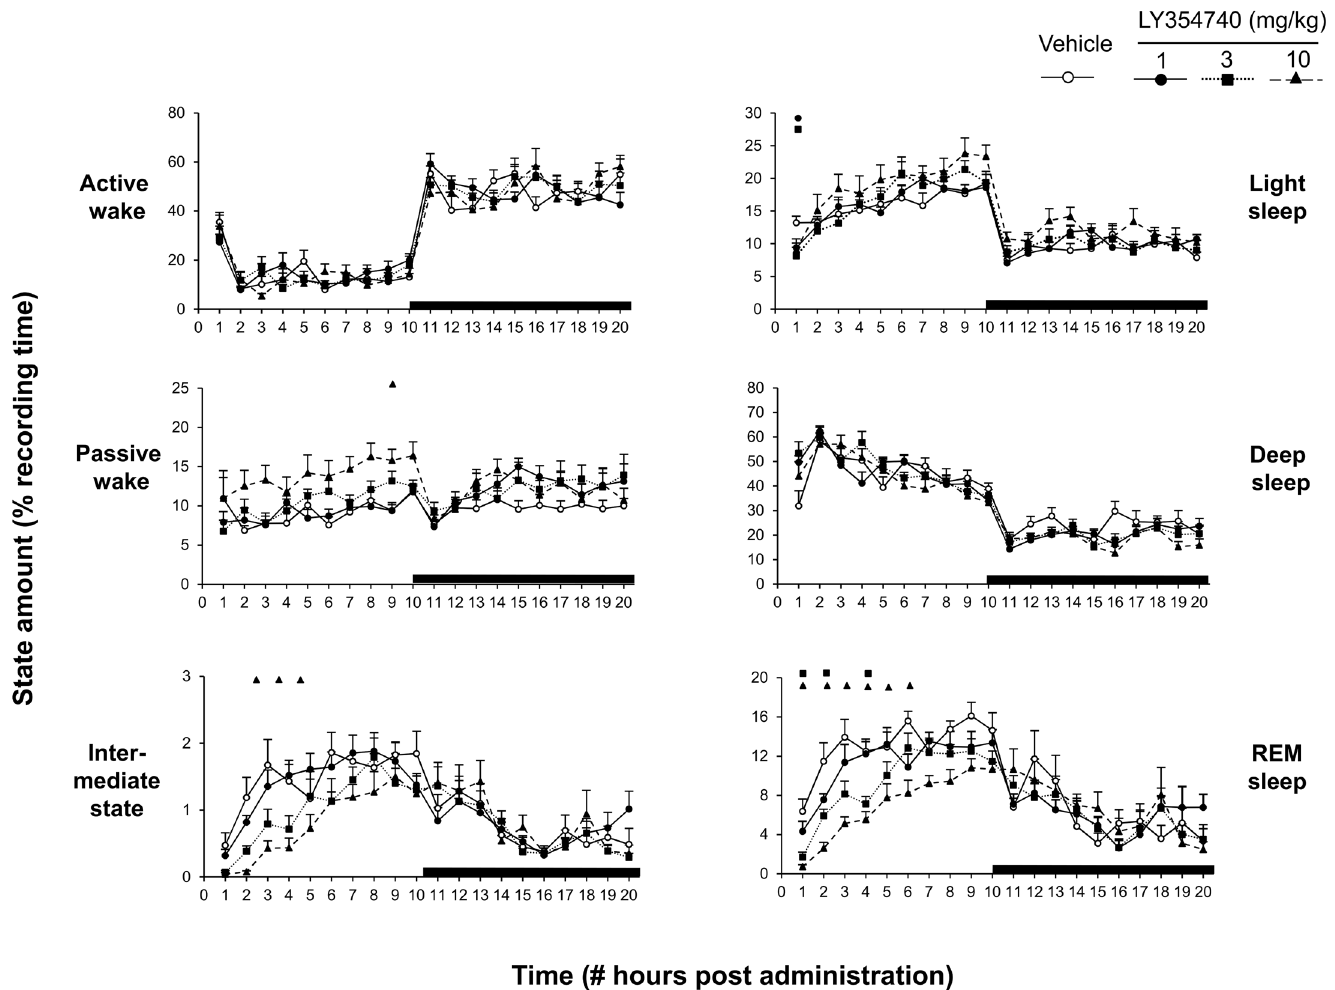
Fig 3. Percentage distribution of the vigilance states active wake, passive wake, intermediate stage, light sleep, deep sleep and rapid eye movement (REM) sleep for each hour period of the 20-h recording session following acute LY354740 (1, 3, 10 mg/kg) or vehicle. Open and dark areas in the abscissa axis indicate light and dark phase of the circadian time, respectively. Values are presented as means ± S.E.M. for each condition expressed in percentage of the recording time. Each symbol indicates statistically significant difference (P < 0.05) between vehicle and drug-dose injected